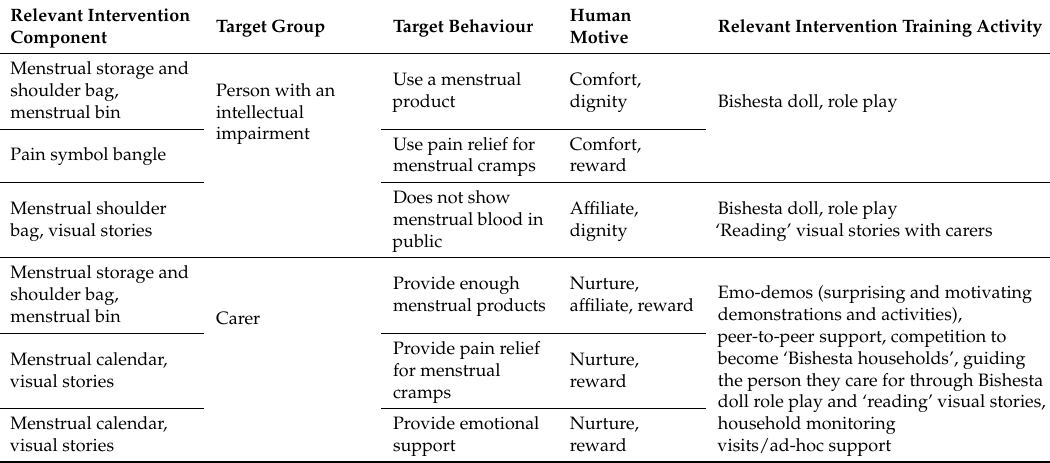
Table 3. Intervention components and training